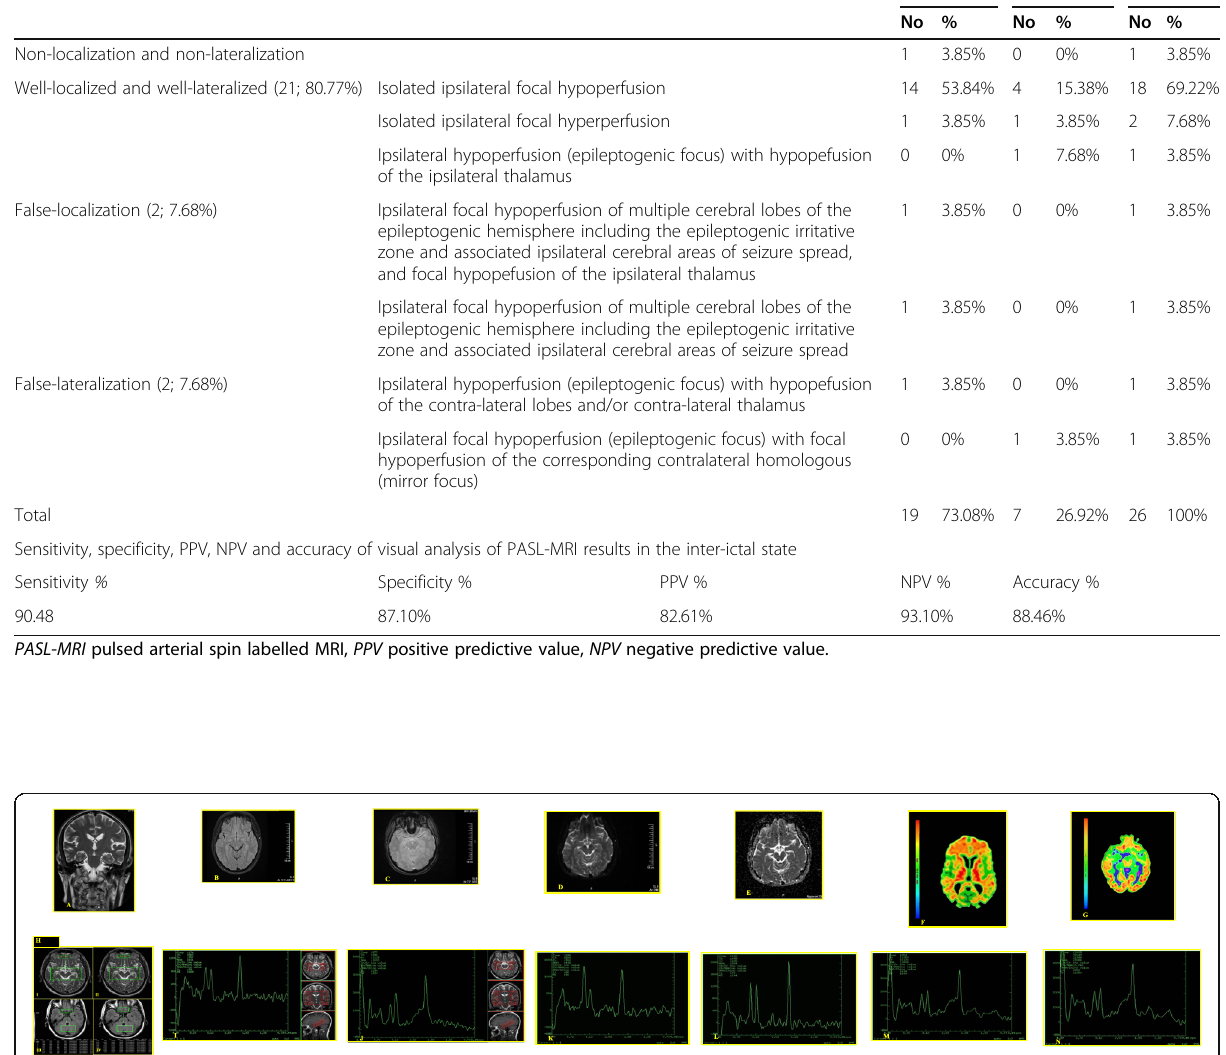
Total perfusion Temporal Extra- temporal No % No % No %